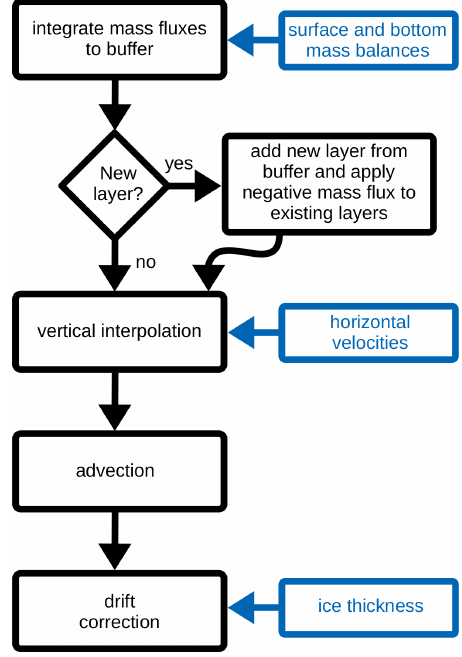
Figure 4. One time step of the layer tracing scheme. Input fields provided by Yelmo are highlighted in